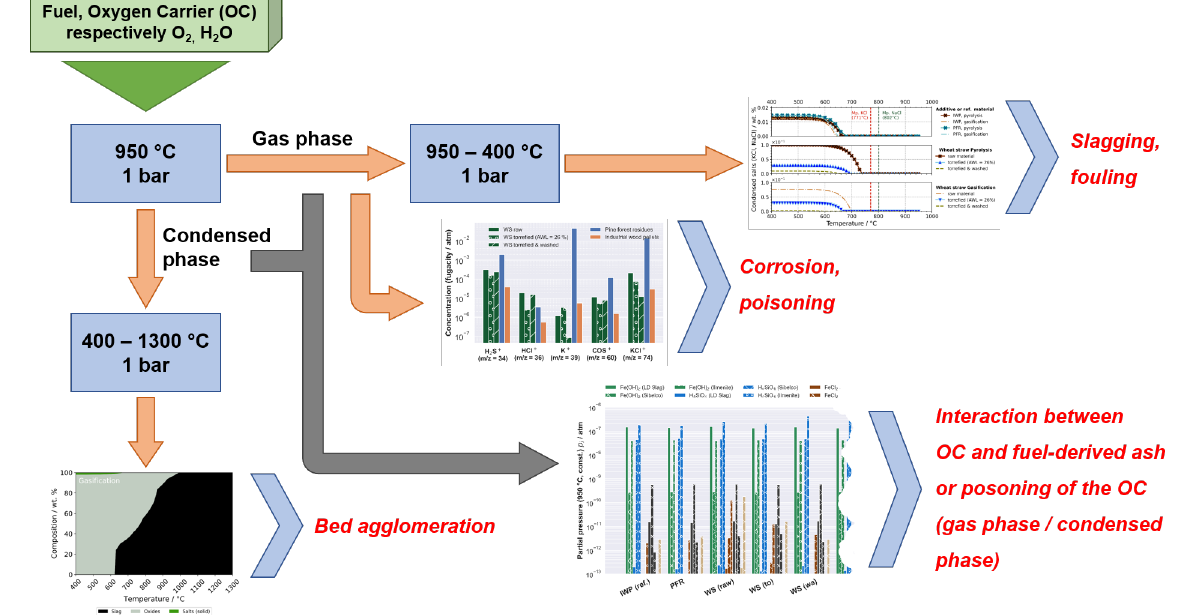
Figure 2. Scheme of the thermodynamic model for investigation of ash related issues in CLG. Equilibrium calculations were carried out with FactSage